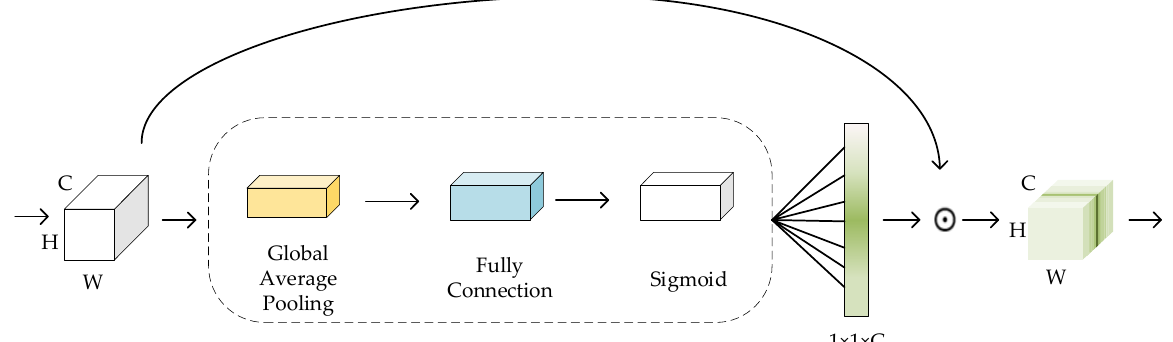
Figure 2. The overall structure of local attention.